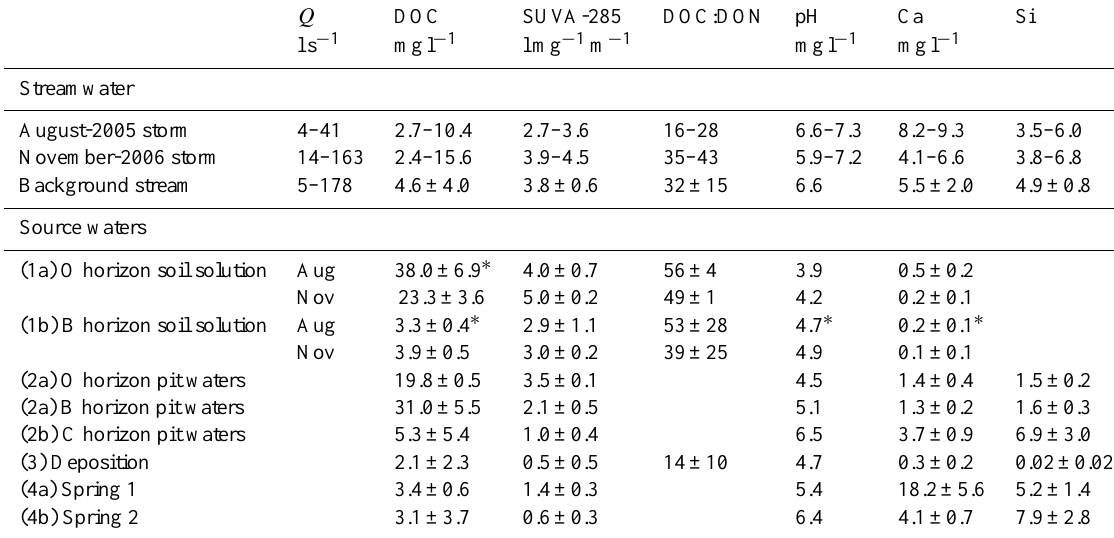
Table 4. Ranges of values for flow ( Q ) and solute concentrations during the two storms compared with the background stream hydrochemistry (2 yr weekly data, n = 98) and (b) catchment source waters 1–4 (mean±1 standard deviation). Two values for soil solutions 1a and 1b denote August and November concentrations from 2004–2006 ( n = 7 for each) with significant differences (denoted as ∗ p < 0.05;